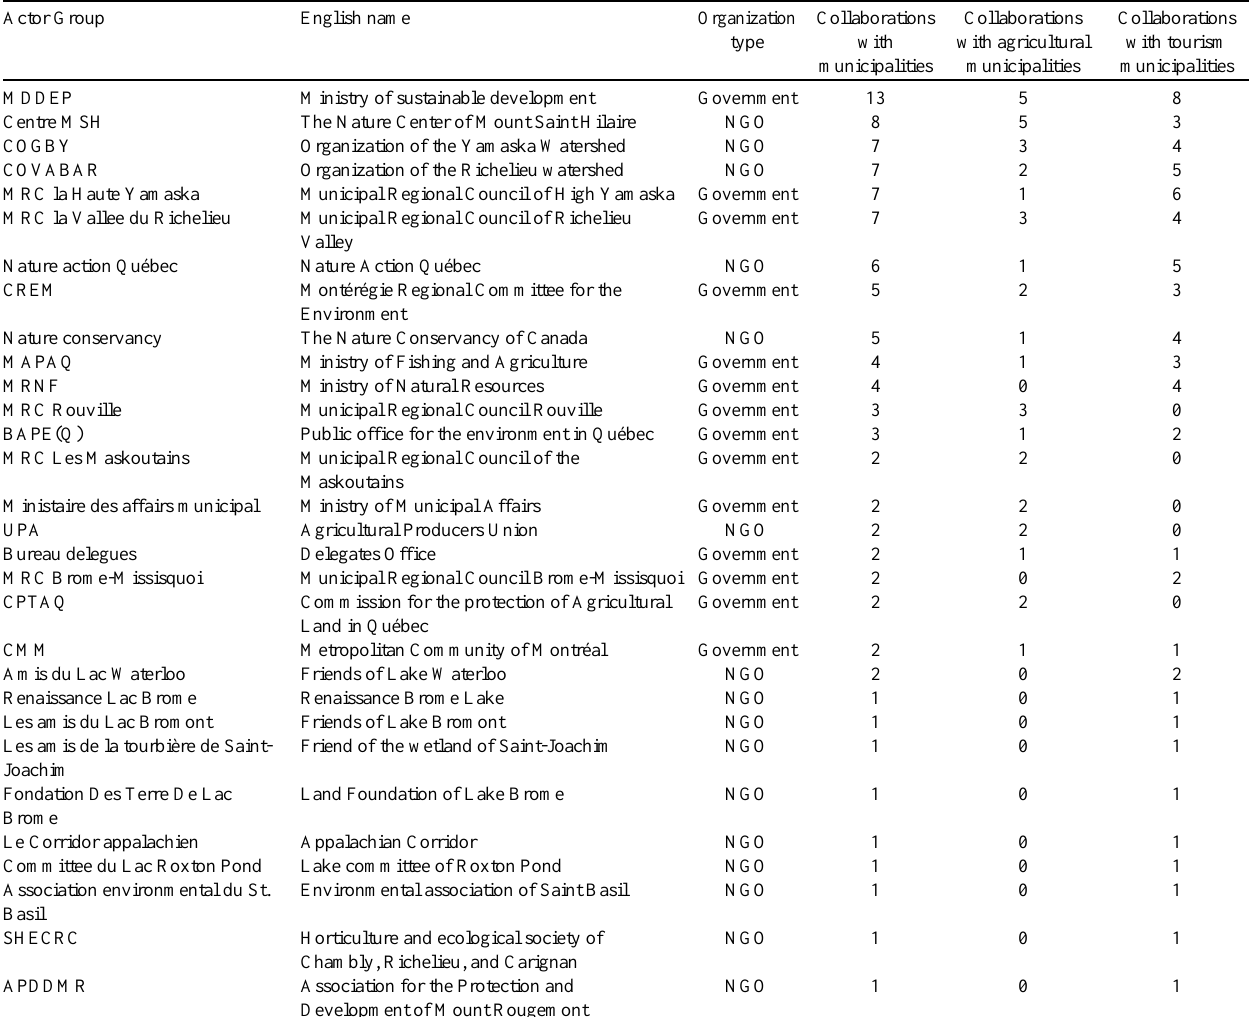
Table 1 . Organizations that collaborate with municipalities on water quality